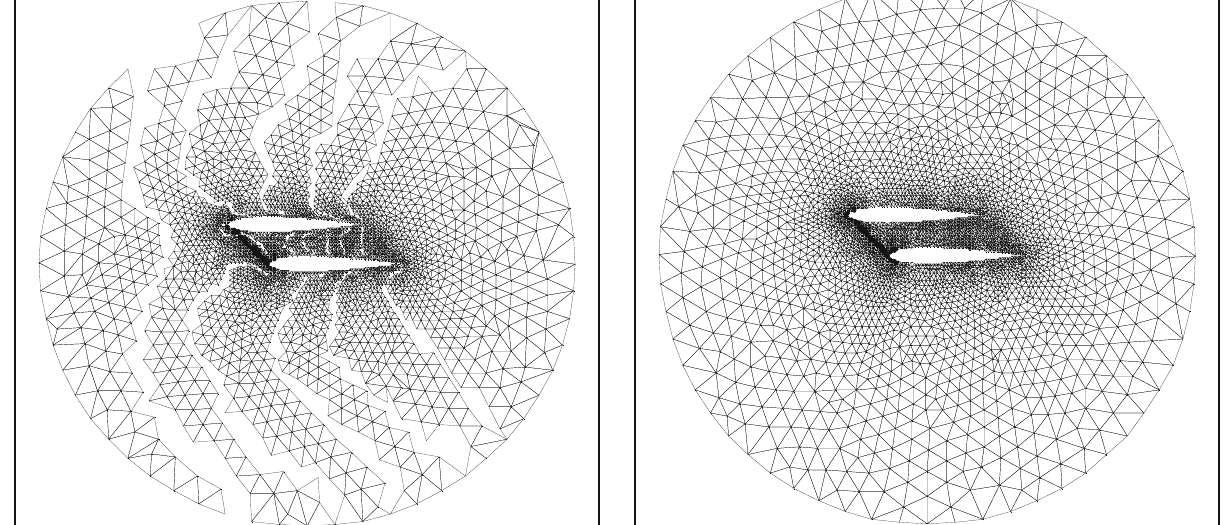
Fig. 9 Double airfoils: gridded subdomains